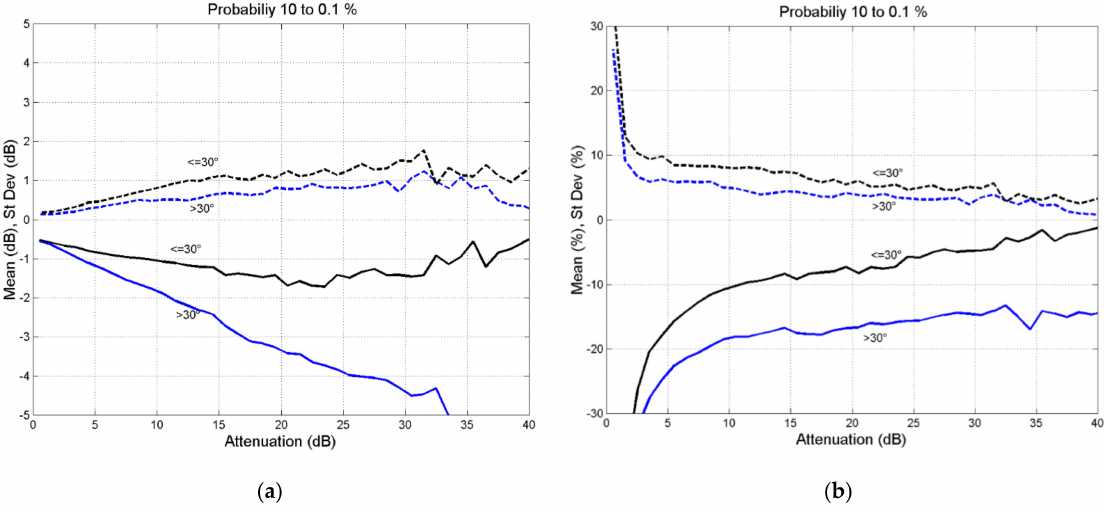
Figure 5. ( a ) Average (continuous lines) and standard deviation (dashed lines) of the error ε versus A SST ; ( b ) ε r . Probability range 10% to